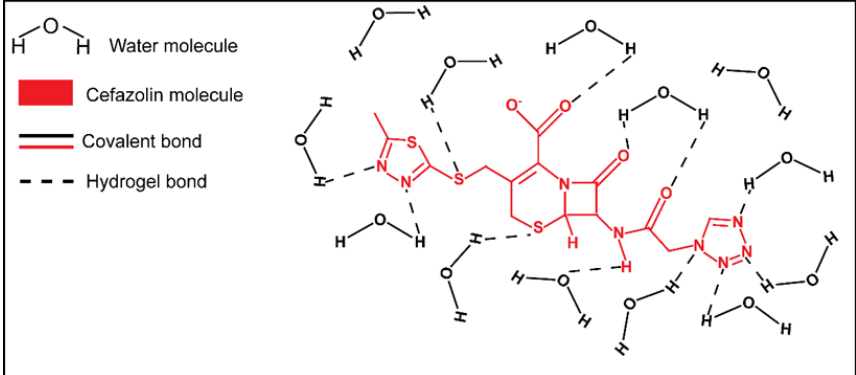
Figure 12. Graphic illustration cefazolin interaction with water molecules at pH 7.4. The polar hydrogen, nitrogen, sulfur, and oxygen atoms can form hydrogen bonds with water